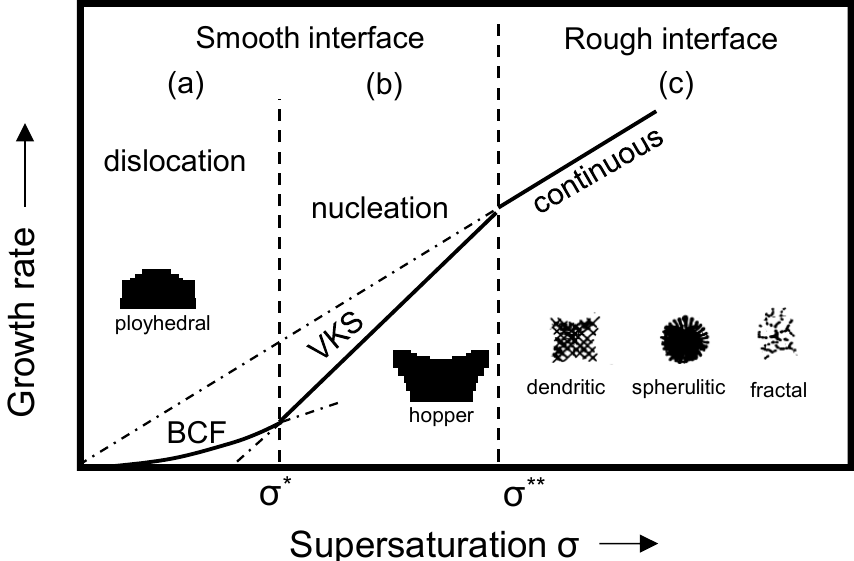
Figure 11. Schematic diagram of the relationship between supersaturation and growth rate for different growth mechanisms. ( a ) BCF model. ( b ) VKS model. ( c ) Continuous growth model. σ * is the transition point between ( a ) and ( b ), σ ** is the transition point between ( b ) and ( c ).